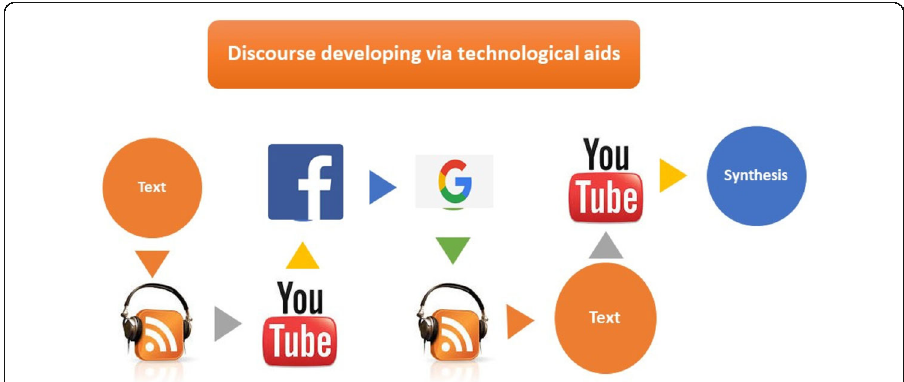
Fig. 3 Discourse developing via technological